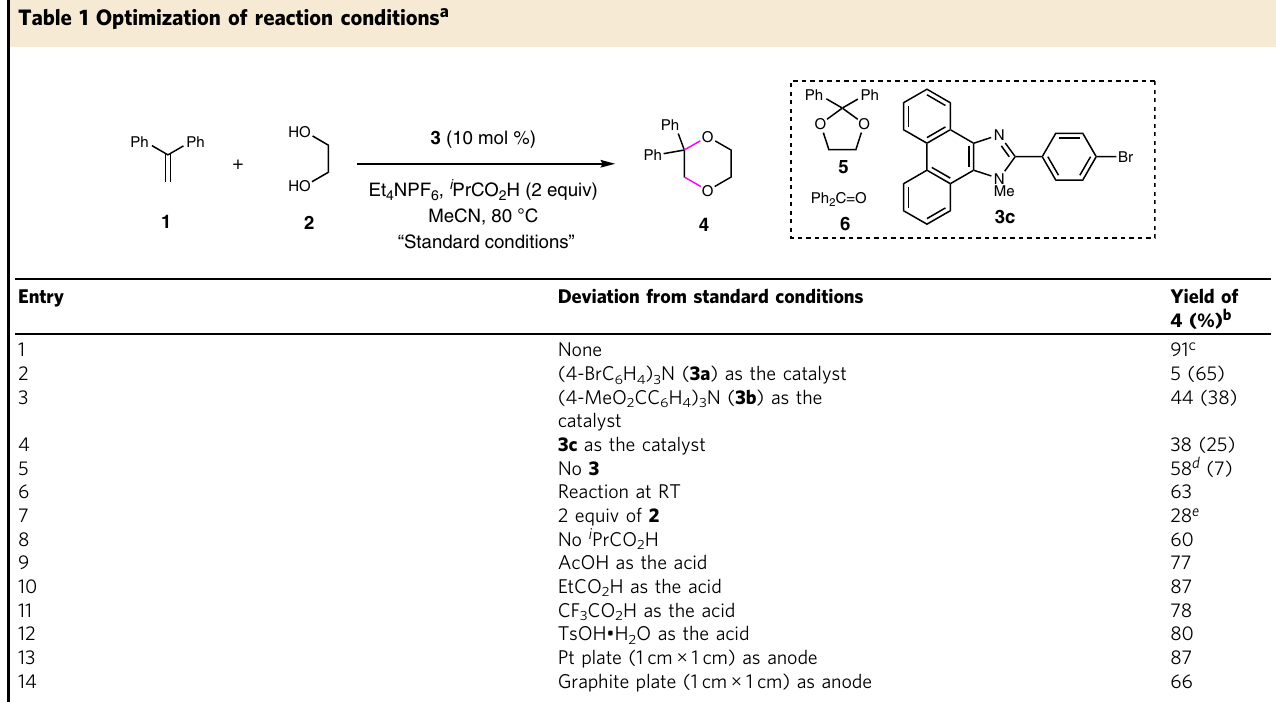
Table 1 Optimization of reaction conditions